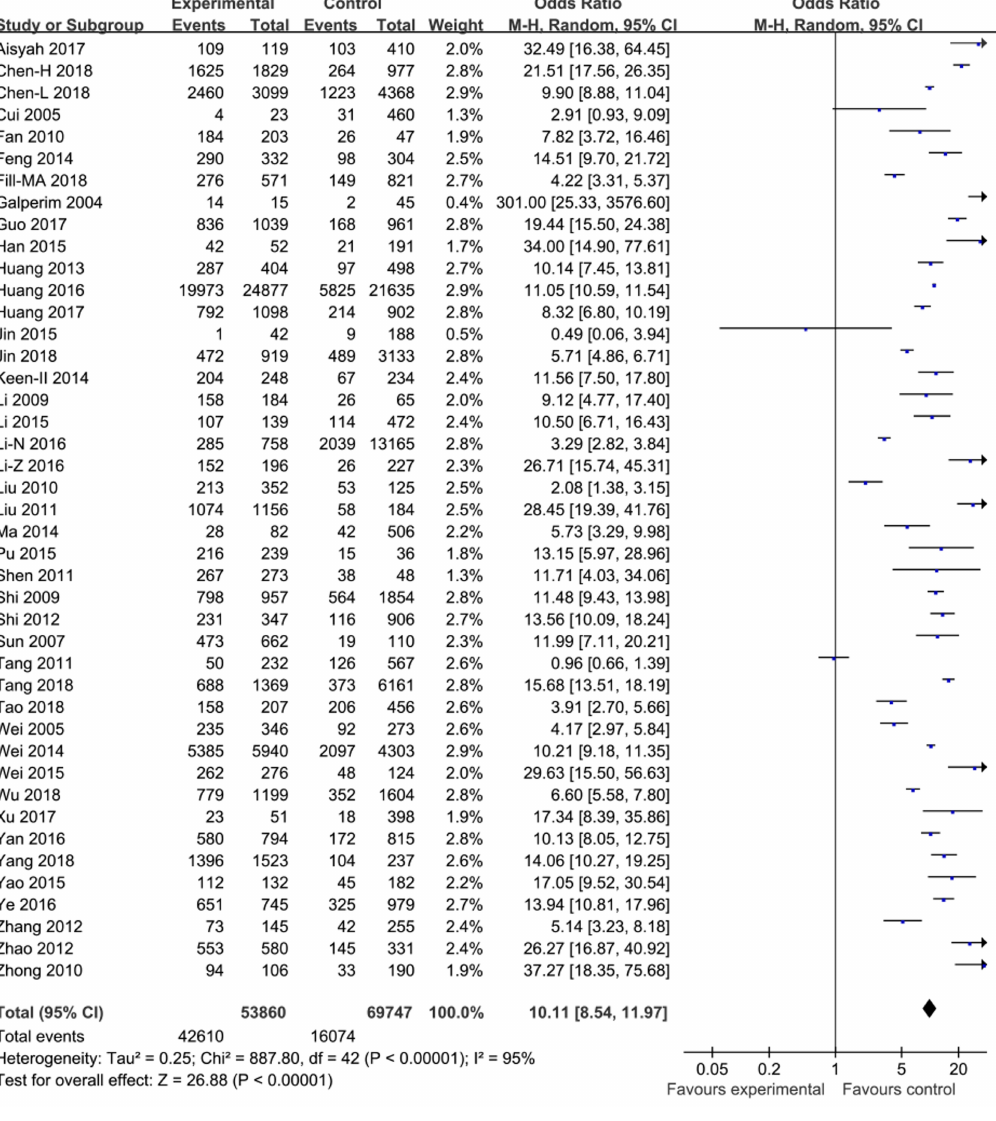
Figure 4. E ff ects of pooled ORs for injecting drug use correlating to the development of HCV infection among drug